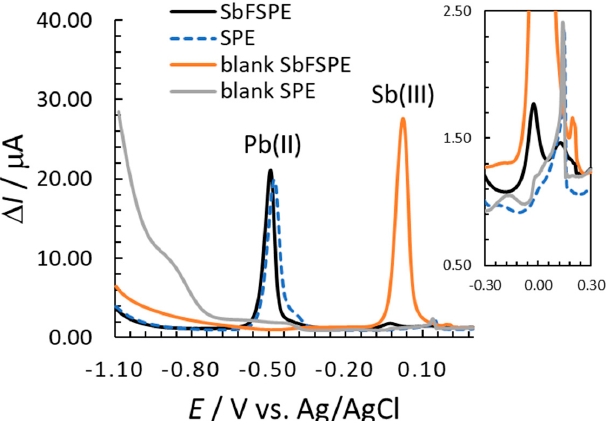
Figure 1 . Blank measurements, stripping signals of Pb(II) and Sb(III) using SbFSPE, and stripping